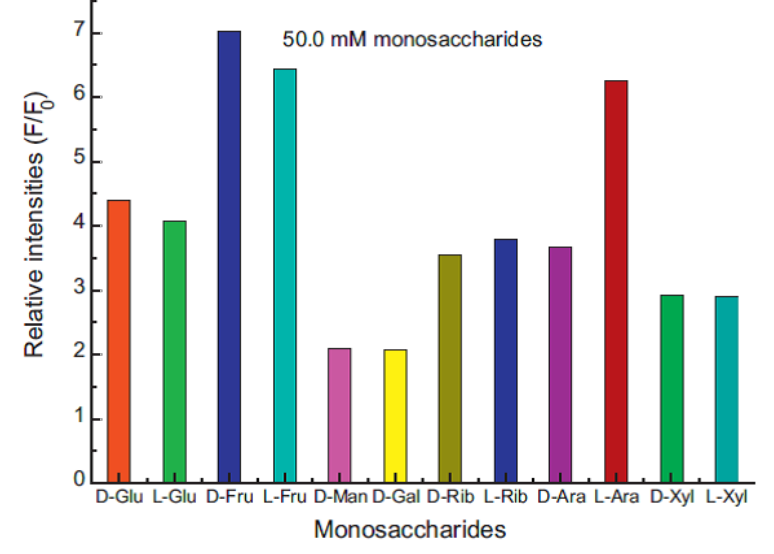
Figure 11. Fluorescence intensity at 467 nm for the system after the addition of 50.0 mM of monosaccharides at pH 7.4 buffer solution. Glu = glucose, Fru = fructose, Man = mannose, Rib = ribose, Ara = arabinose, Xyl = xylose (reproduced from